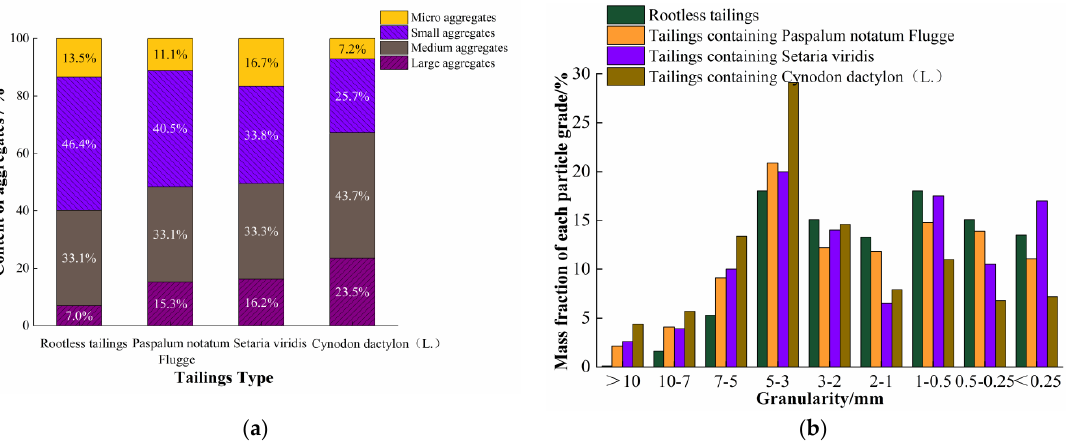
Figure 7. Distribution characteristics of aggregates. ( a ) Effect of root system on aggregates’ content; ( b ) particle size distribution of aggregates. ( b ) particle size distribution of